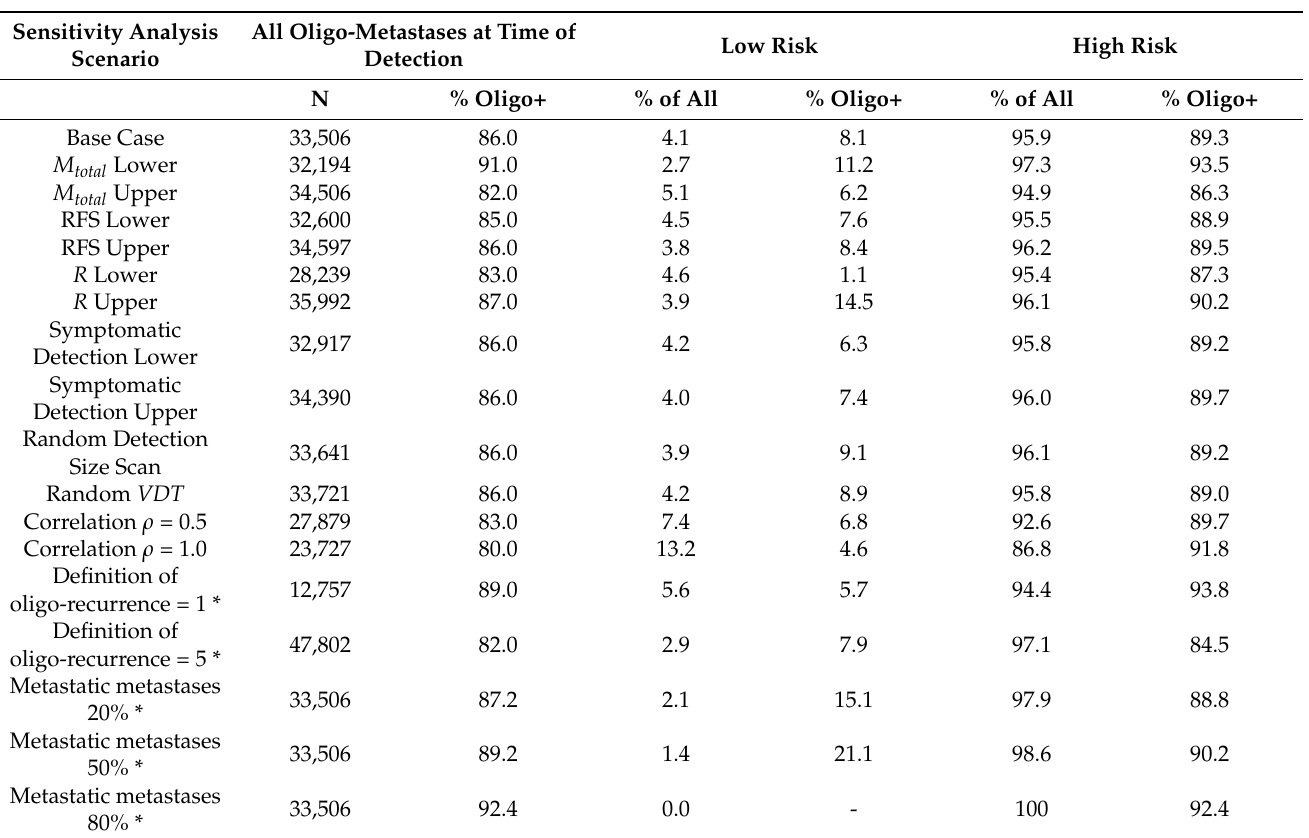
Table 6. Proportion of detected oligo-metastases that fall into the risk groups and proportion of oligo+ within the risk groups per